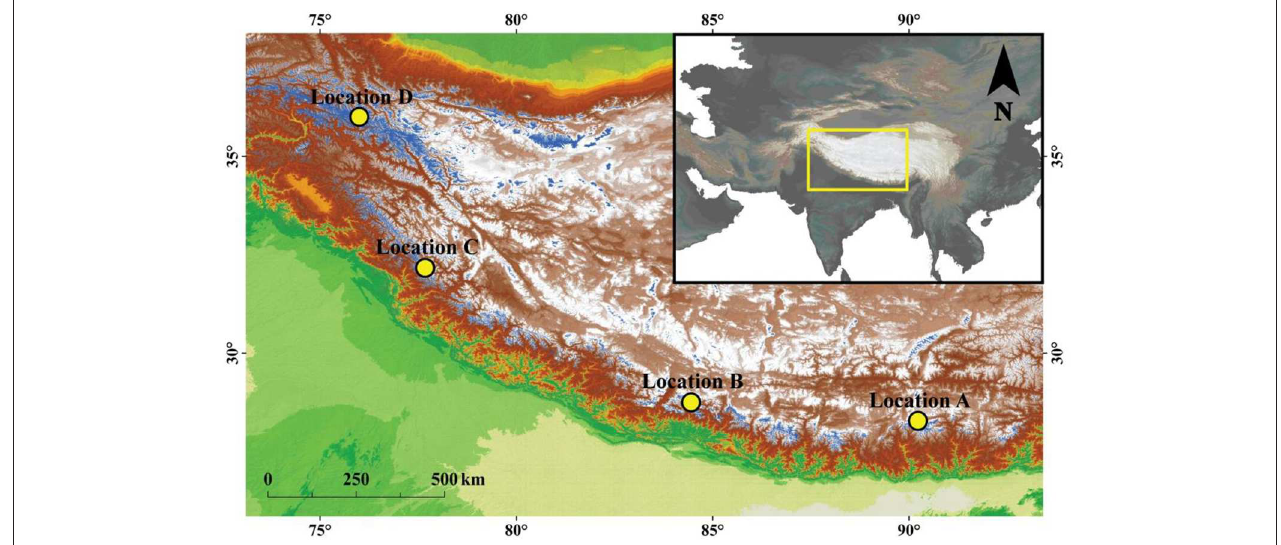
FIGURE 1 | Region of High Mountain Asia, with glaciers outlined in blue and the specific climate regions considered in the study as yellow points. Glacier outlines were obtained from the Randolph Glacier Inventory version 6.0 (2017).